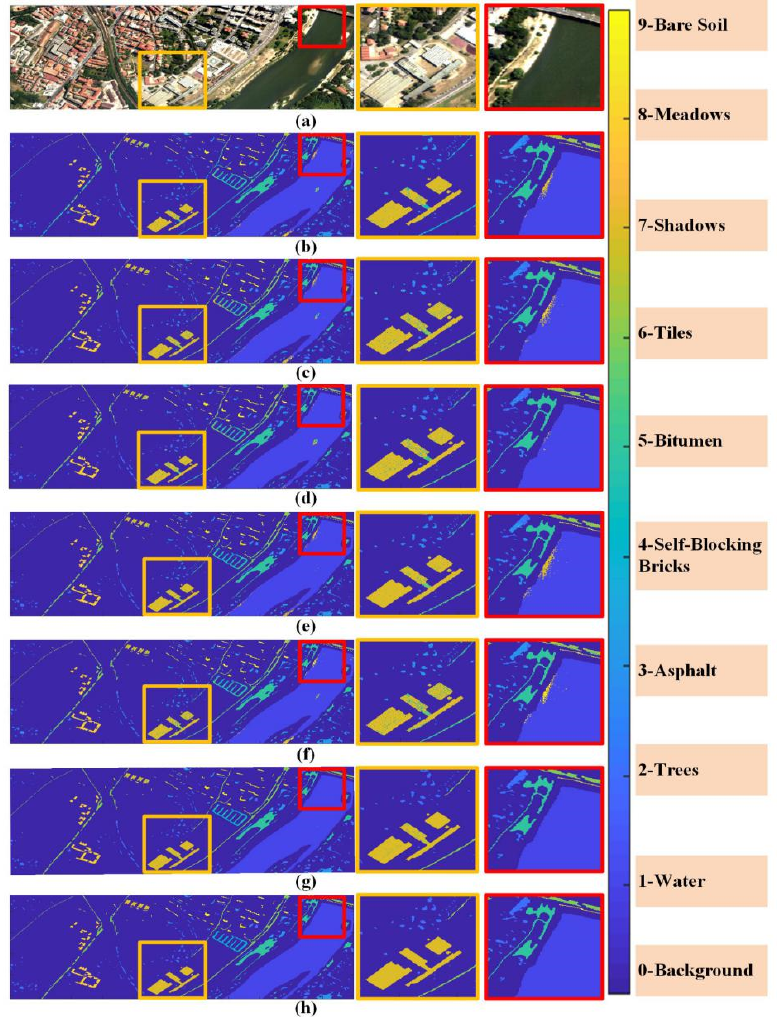
Figure 8. Classification maps of the Center of Pavia dataset with methods in comparison: ( a ) pseudo- color image; ( b ) FDDL; ( c ) DPL; ( d ) ResNet; ( e ) RNN; ( f ) CNN; ( g ) Ours; ( h ) ground truth. The yellow and red rectangles correspond to building and water